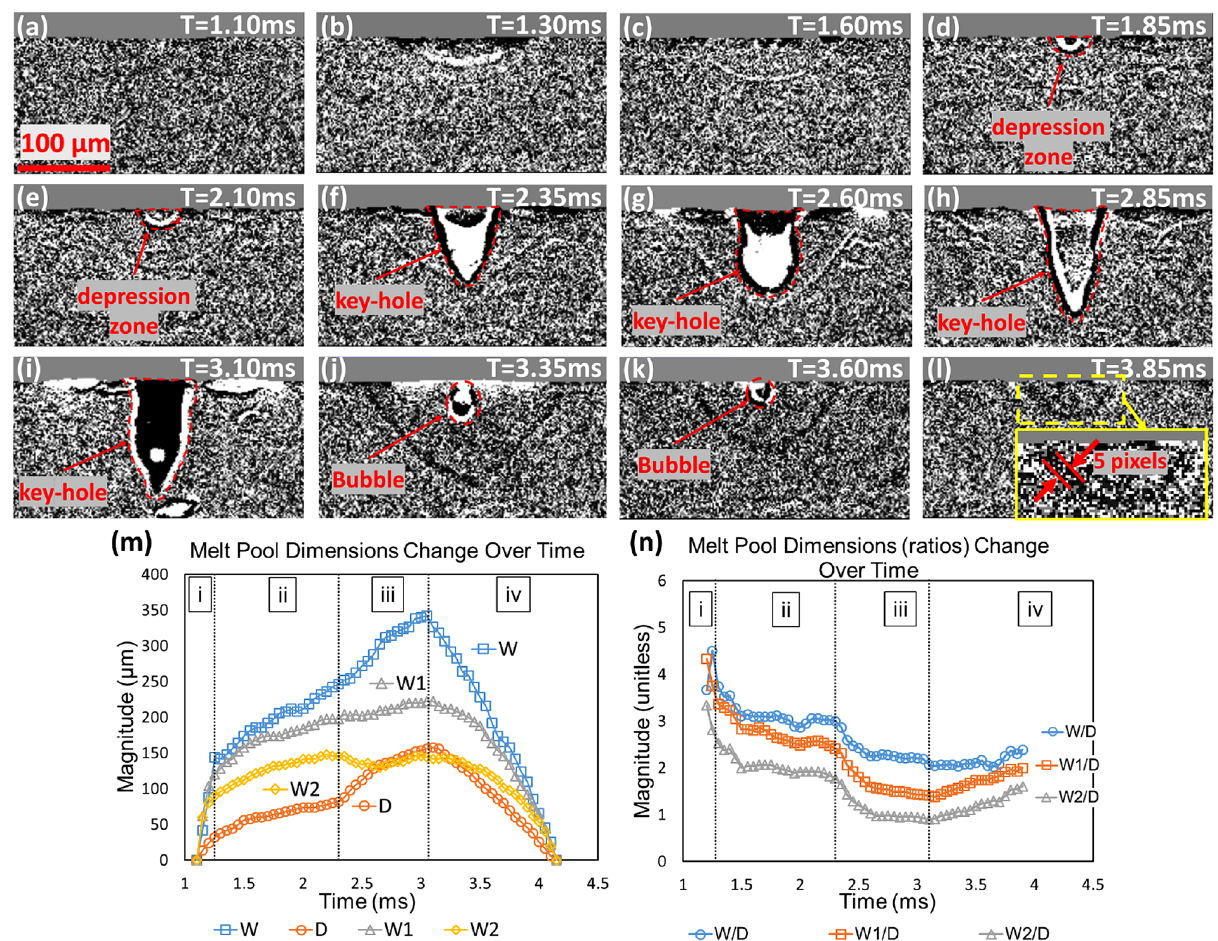
Figure 3. ( a – l ) The selected high-speed X-ray images of the melt pool of Trial #20. From the X-ray observations, phenomena such as keyholes and bubbles can be seen. ( m ) The melt pool dimensions change over time where blue squares, orange circles, gray triangles, and yellow diamonds represent the size of W , D , W 1 , and W 2 , respectively. Intervals i, ii, iii, and iv represent initial heating, conduction melting, keyhole melting, and cooling, respectively. ( n ) The melt pool dimension ratios change over time where blue circles, orange squares, and gray triangles represent the W / D , W 1 / D , and W 2 / D , respectively. Notice that W and D have a constant rate of change during the cooling process. The uncertainties of the extracted dimension values are ± 4